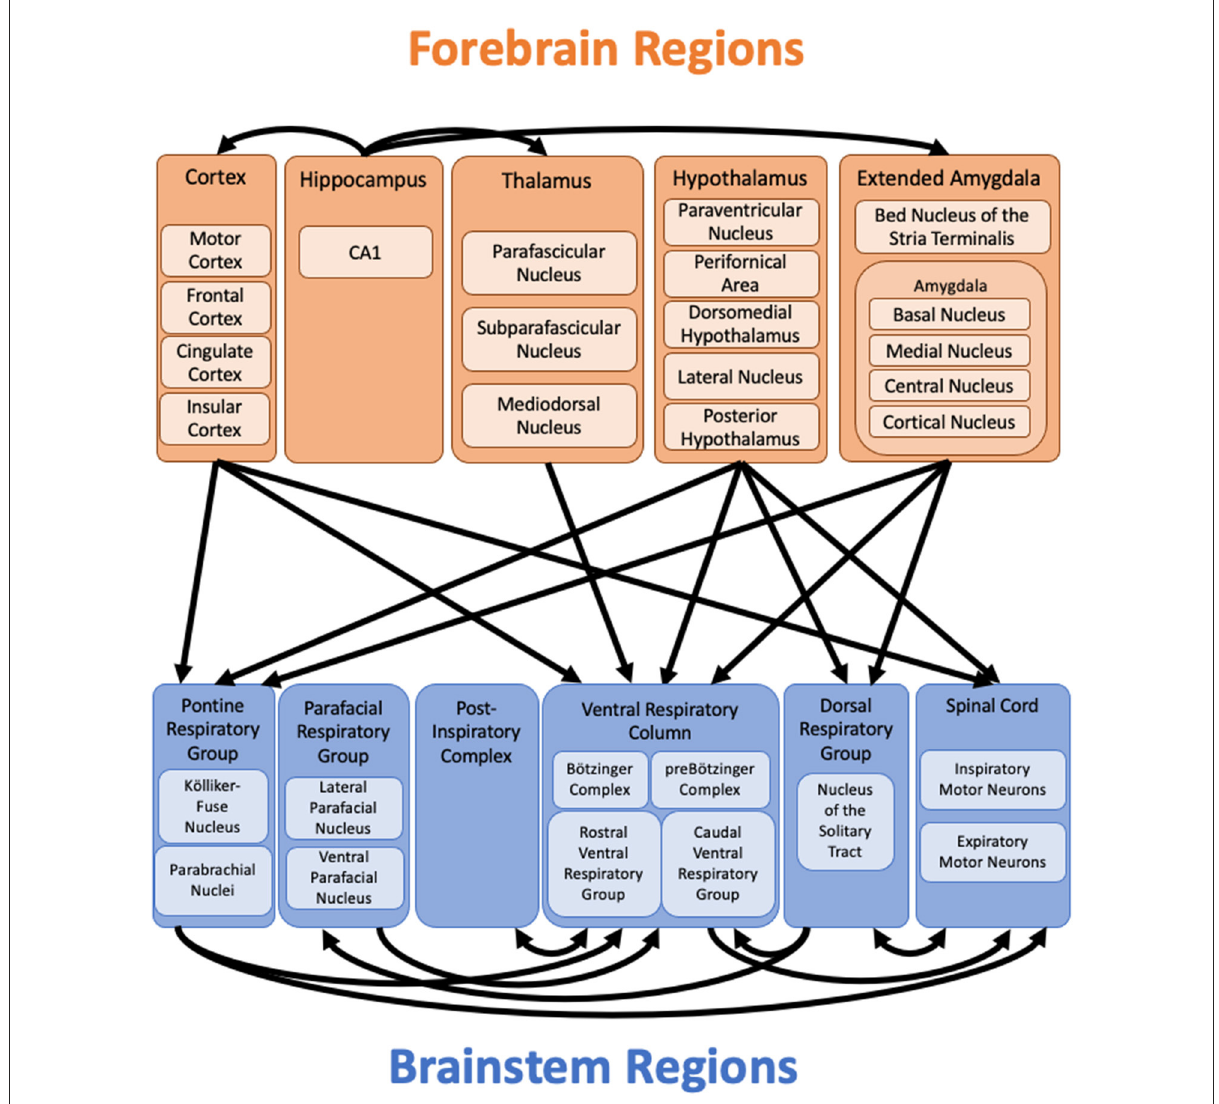
FIGURE2 Forebrain projections to brainstem respiratory regions. Diagram of known projections from forebrain regions to brainstem respiratory regions as discussed in the text. Connections from the brainstem to forebrain regions are not shown. Connections from the hippocampus to other forebrain regions highlight potential pathways through which the hippocampus might influence respiration in lieu of known direct projections to brainstem respiratory regions. The extensive connections between other forebrain regions are not shown. Important connections within the brainstem highlight additional pathways through which the forebrain might influence breathing, even in the absence of direct connections to specific brainstem respiratory regions. Additional regions, such as the cerebellum and periaqueductal gray (not shown), may relay information from the forebrain to the